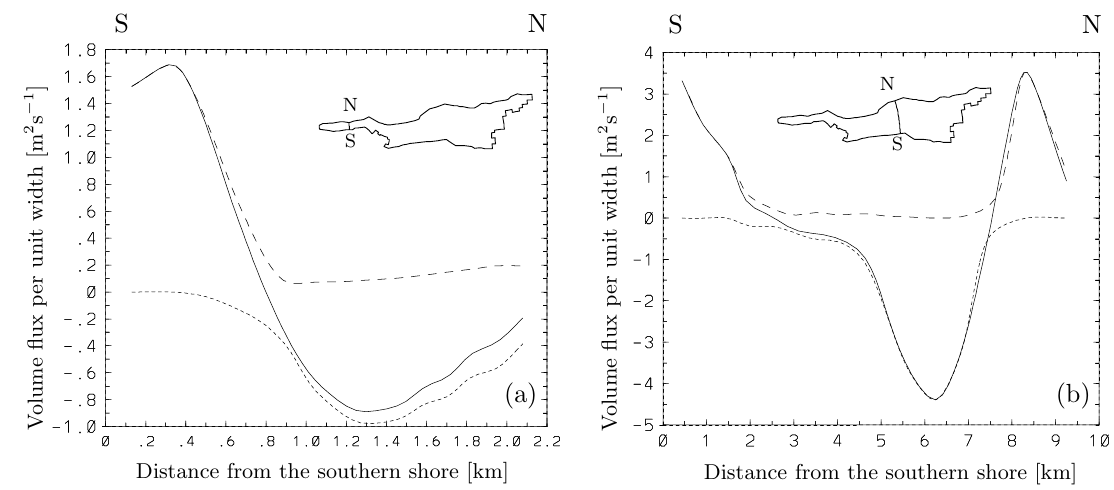
FIG. 20: Vertically integrated volume flux per unit width in the ¨Uberlinger See (a) and in the Obersee Fig. 20. Vertically integrated volume flux per unit width in the ¨ Uberlinger See (a) and in the Obersee (b) computed with the vertical eddy (b) computed with the vertical eddy viscosity ν v = 0 . 005m 2 s − 1 . Broken curves indicate the transport part viscosity ν v = 0 . 005 m 2 s − 1 . Broken curves indicate the transport part along the wind direction, dotted curves against the wind. The solid along the wind direction, dotted curves against the wind. The solid lines show the sum of the two. The lines show the sum of the two. The location of the cross-sections is shown as insets. location of the cross-sections is shown as insets.